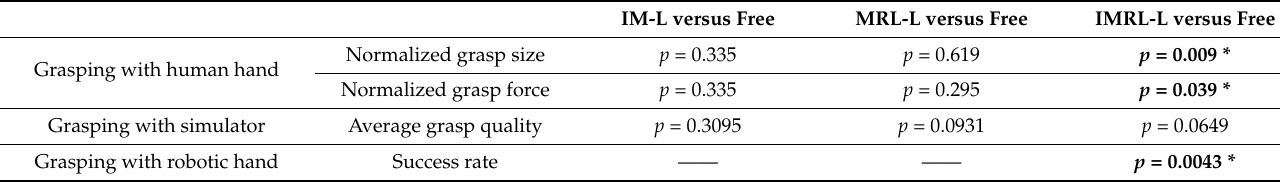
Figure 6. Results of the disk-tower test. ( a ) Grasp size, ( b ) normalized grasp size. Table 2. Results of Wilcoxon